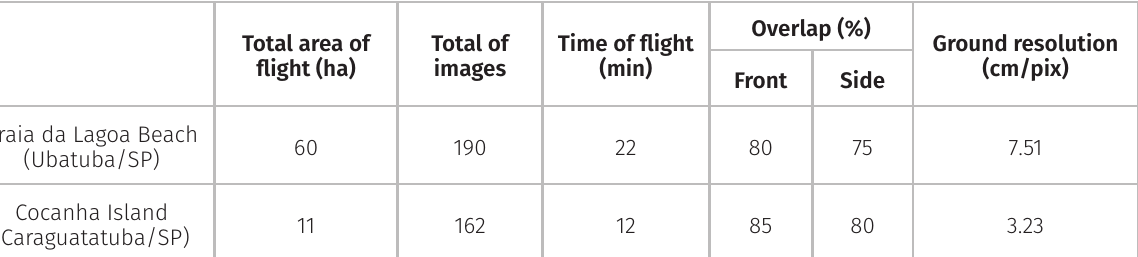
Overlap (%) Total area of Total of Time of flight Ground resolution flight (ha) images (min) (cm/pix) Front Side 60 190 22